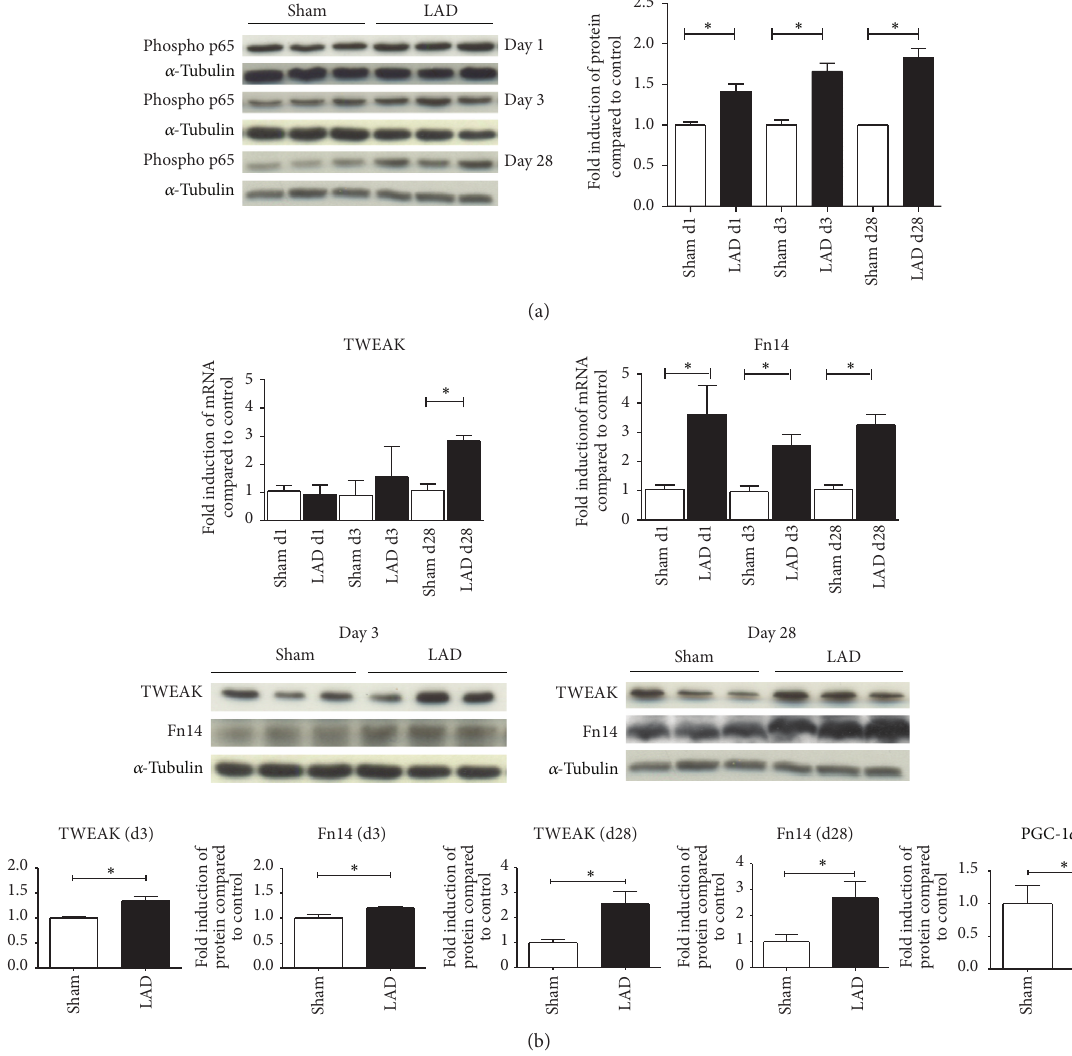
Figure 2: Activation of NF-kB pathway and expression of TWEAK and Fn14 in the remote myocardium after MI. (a) Progressive activation of NF-kB signaling demonstrated by increased phosphorylation of p65 could be observed in the remote myocardium of mice after LAD ligation. Representative western blots ( 𝑛 = 5 for sham; 𝑛 = 6 for LAD at each time point). (b) RT-PCR analysis of TWEAK and its receptor Fn14 revealed that both were upregulated in the remote myocardium. However, whereas Fn14 expression occurred rapidly after MI in the remote zone and remained consistently elevated, TWEAK expression increased later. Western blot analyses for TWEAK and Fn14 in the remote myocardium confirmed these findings ( 𝑛 = 5 for sham; 𝑛 = 6 for LAD at each time point). Likewise we observed reduced expression of PGC-1 𝛼 in the failing myocardium after